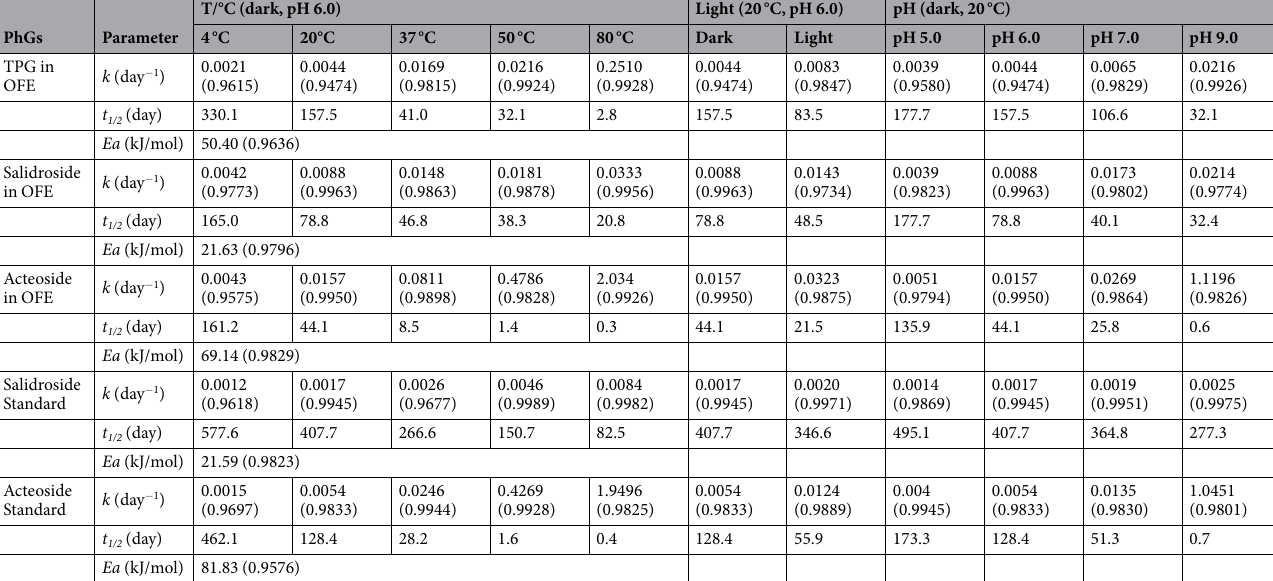
Table 1. The k , t 1/2 and Ea values of phenylethanoid glycosides degradation under different conditions. k , the